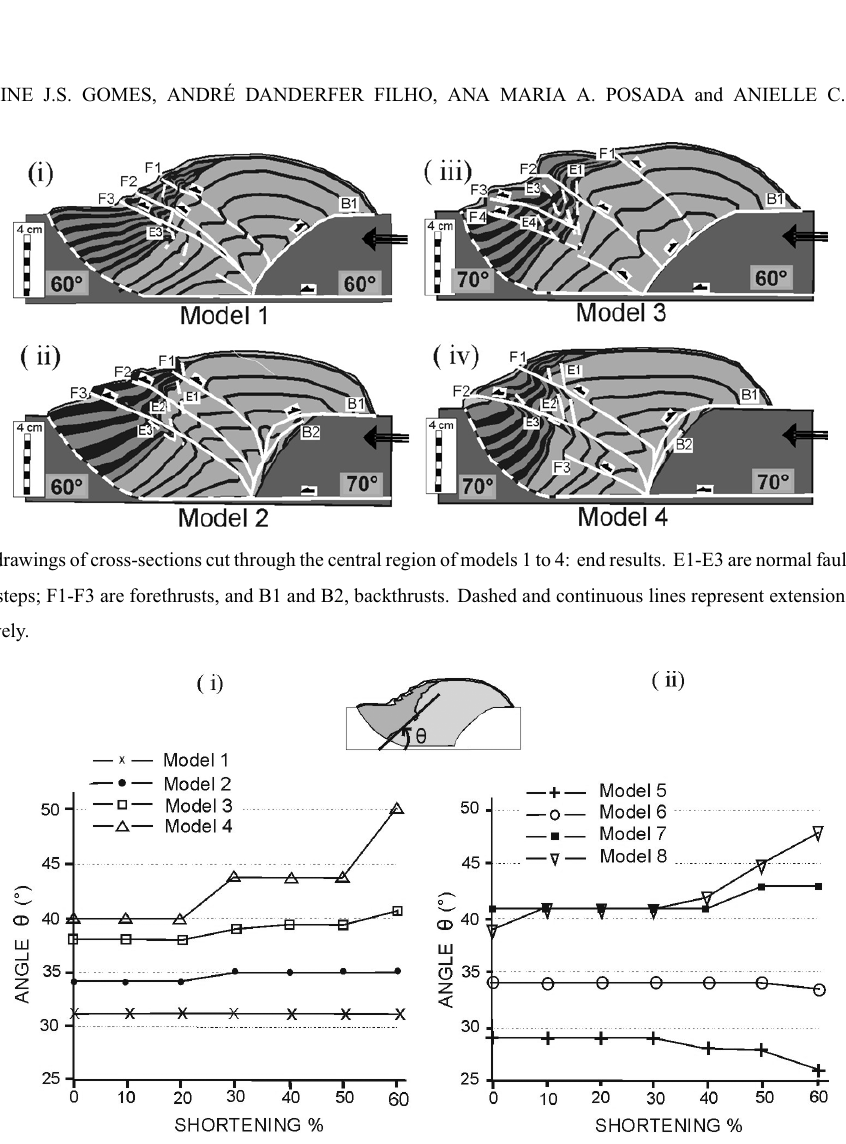
Fig. 6 – Plot of the angle between layering in the sand pack and the normal detachment (angle θ shown in the inset) vs. shortening (%) for the inversion experiments with (i) a convex-up mobile backstop (models 1 to 4) and (ii) a concave-up mobile backstop (models 5 to 8). Experiments with a steep-dipping normal detachment ( β = 70 ◦ ; experiments 3, 4, 7, and 8) produced greater counterclockwise rotation of the sand